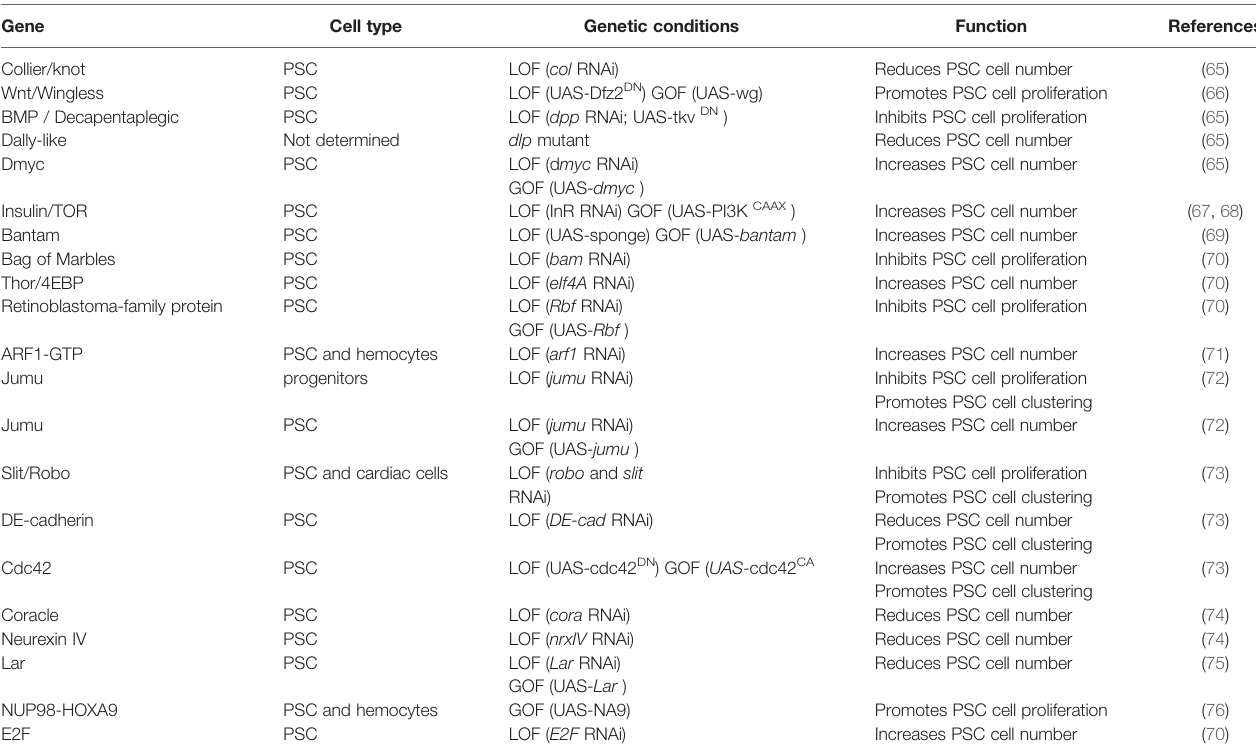
TABLE 1 | Genes and pathways involved in controlling the number of PSC cells and their cohesion. Gene Cell type Genetic